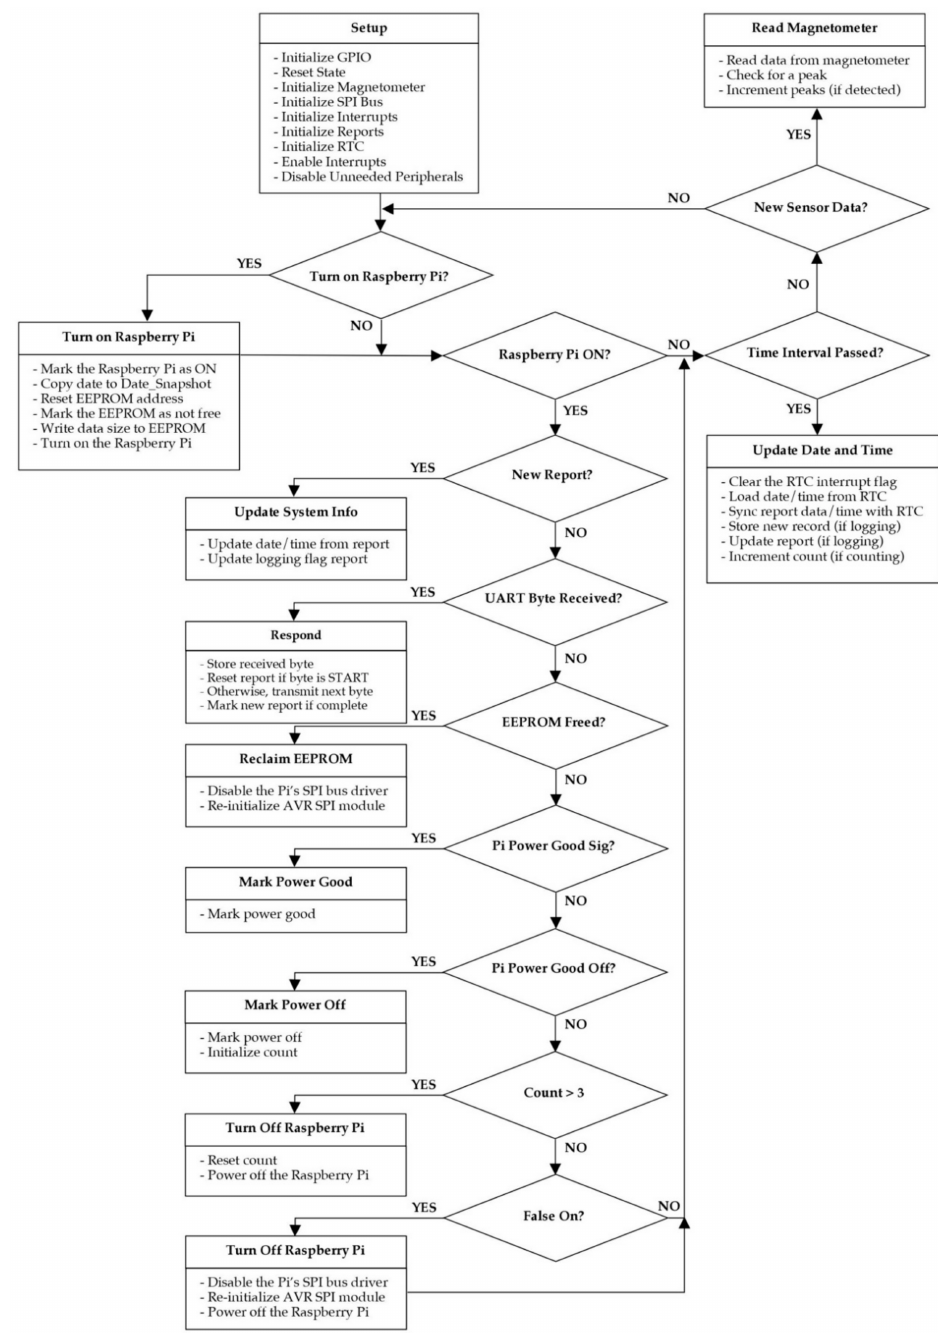
Figure 4. CIWS firmware